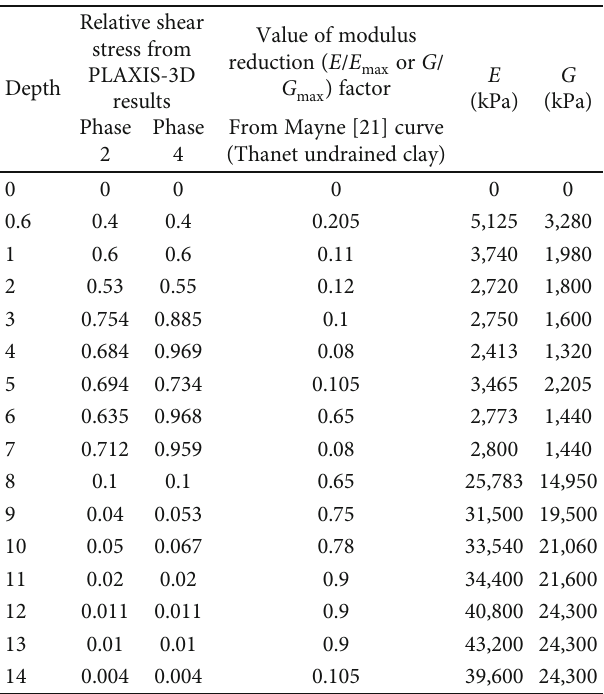
Table 8: Calculation of modulus reduction factor and corresponding elastic modulus ( E ) and shear modulus ( G ) from shear